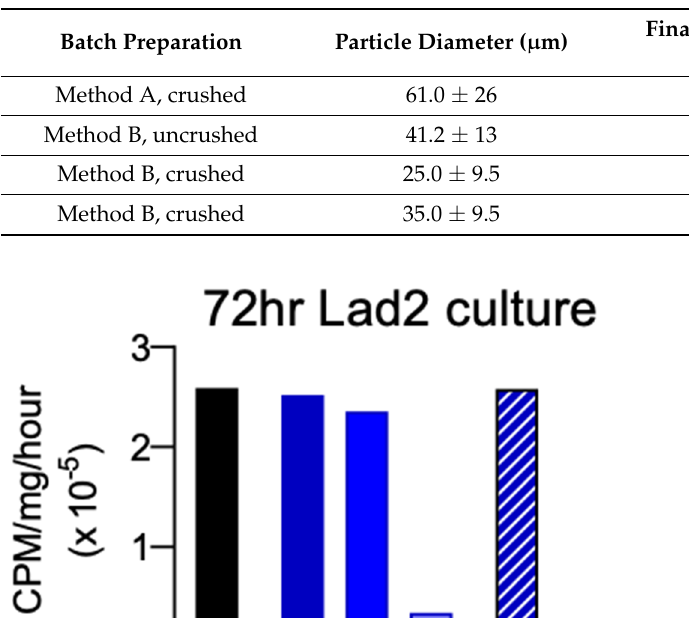
Figure 3. Overview of β-CD microparticle preparation. β-CD prepolymer is crosslinked with EDGE for 3 h at elevated temperature (60–70 °C ) and formed in a water/oil (w/o) emulsion. Table 2. Microparticle batches synthesized with varying temperature and mixing speeds. Particles were then loaded with (+)SW033291 for 24 h (DMSO). Particle diameters were determined by ImageJ, and are presented as the mean ± S.D. Final loading concentrations were determined via LC/MS at UTSW.